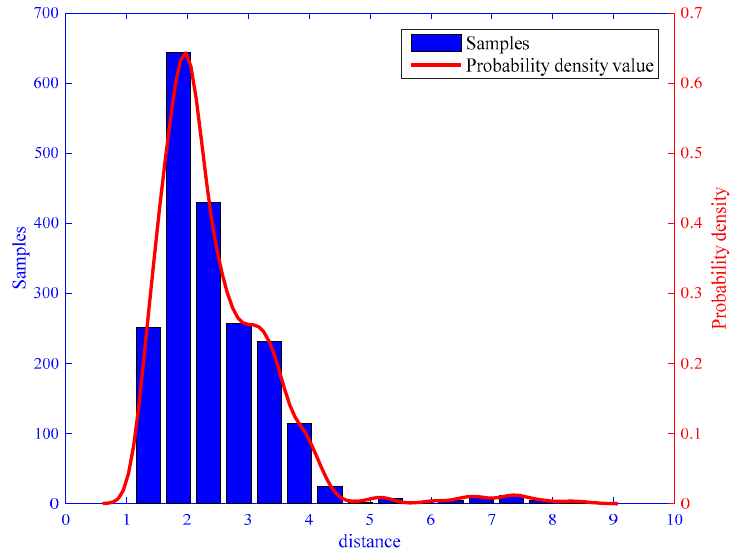
Figure 2. Fitting for probability density function.